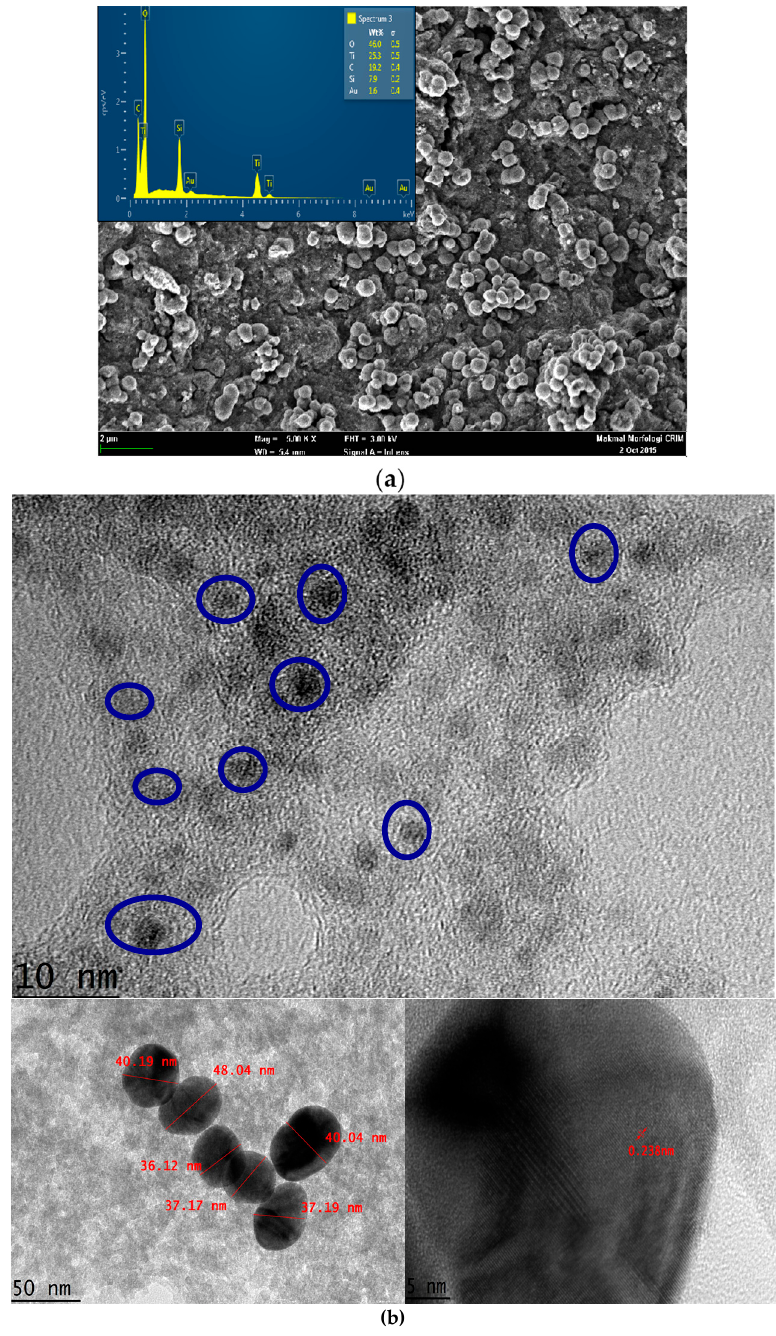
Figure 2. ( a ) TiAu-APTS under SEM with the inset of EDX spectrum and ( b ) Morphology of TiAu-APTS under TEM. The blue circle shows the Au colloid that is embedded with TiO 2 particles in an amorphous state. The bottom left inset is an Au nano colloid with TiO 2 particles. The bottom right inset shows the Au nano colloid crystal with d = 0.2368 nm.